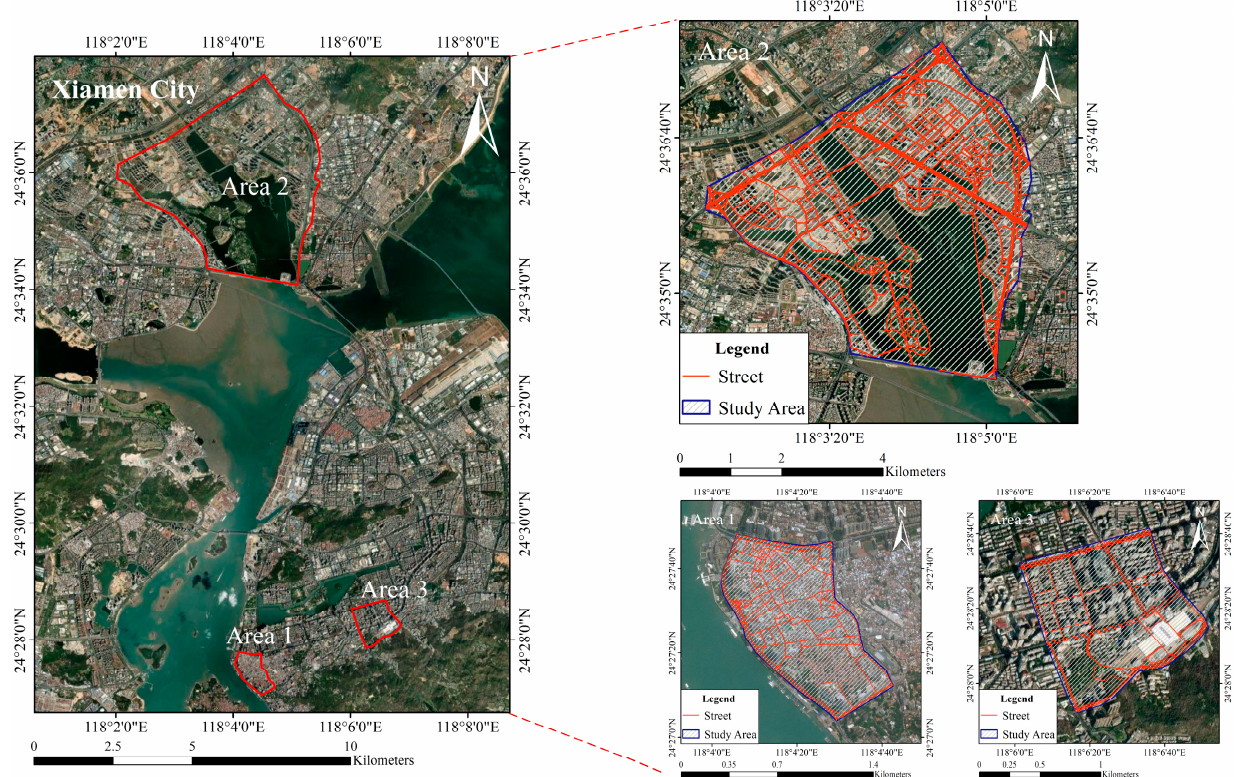
Figure 1. Specific areas studied in Xiamen, China.